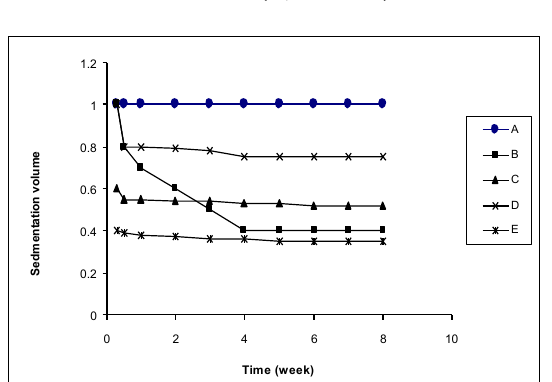
Figure (9): Sedimentation volume of formulas (A, B, C, D and E) The sediment volume measured according to the ratio of the final height of the sediment after settling (Vu) to the initial height of the total product (V ). 0 VoVu F  --------